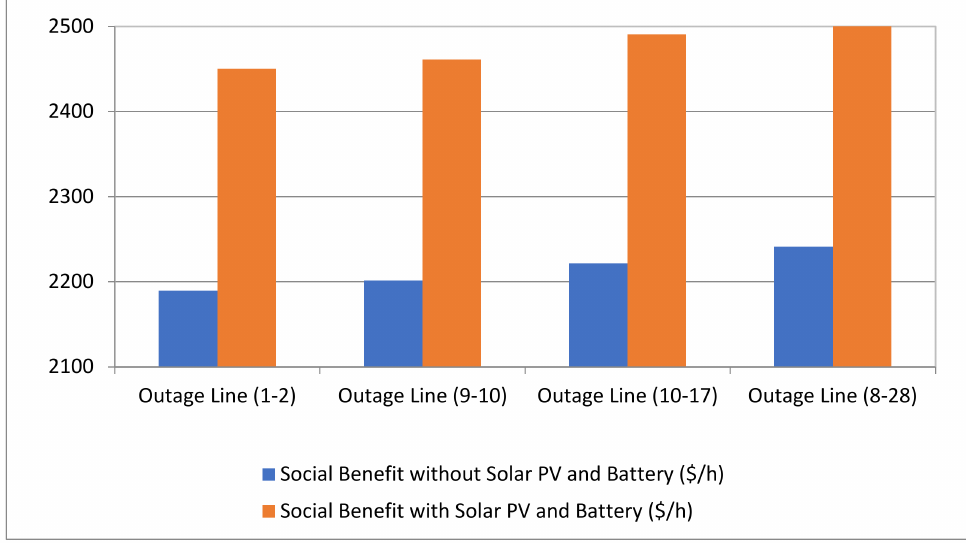
Figure 9. Social benefit with and without solar PV and battery system in IEEE 30 bus system using